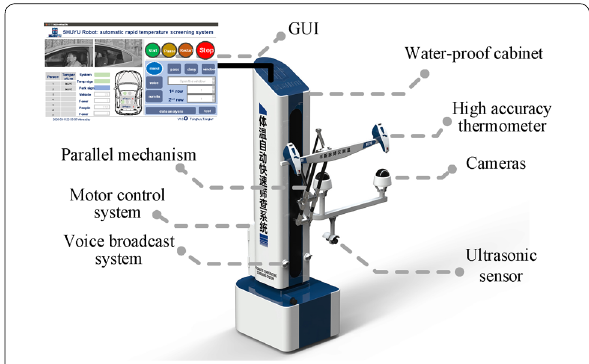
Figure 2 Structure of the SHUYU